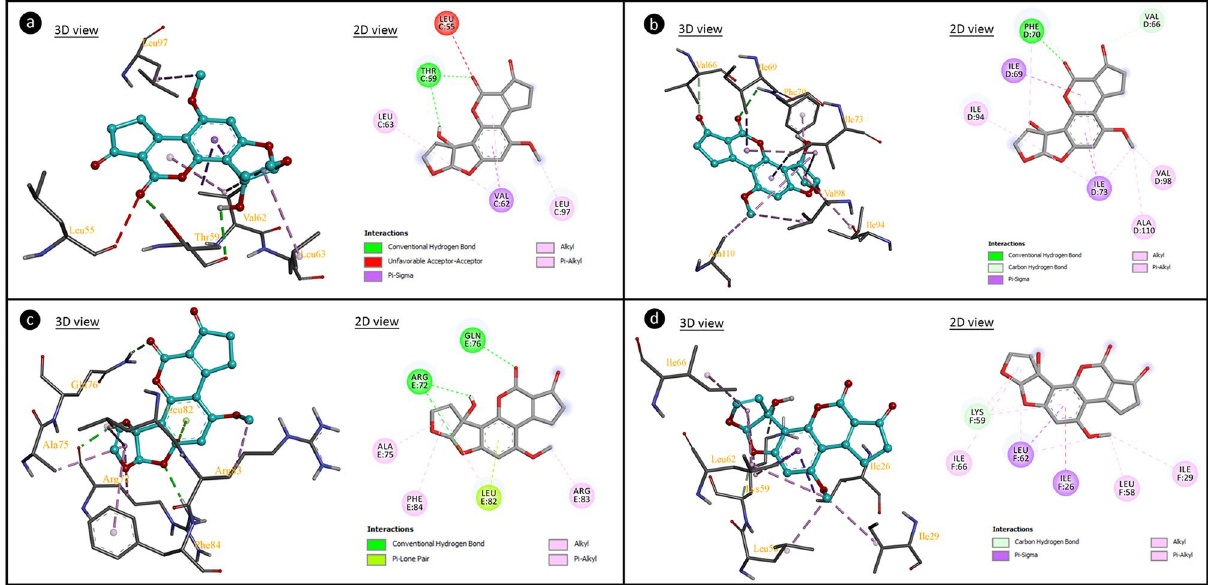
Figure 6. The molecular interactions of AFM 1 with histone proteins ( a : histone H3.1, b : histone H4, c : histone H2A, d : histone H2B type 1A).